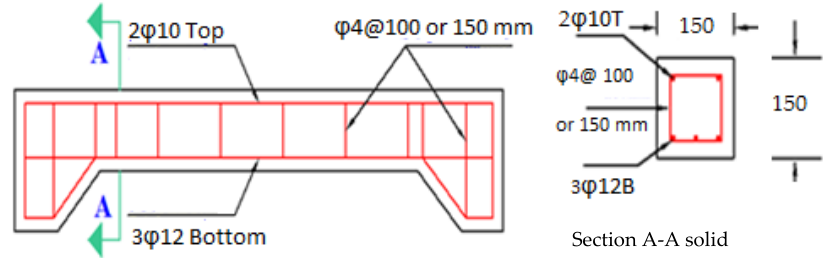
Figure 2. Solid non-prismatic RC beams with reinforcements and section details. Reprinted from Ref. [23]. Figure 2 . Solid non-prismatic RC beams with reinforcements and section details [23].